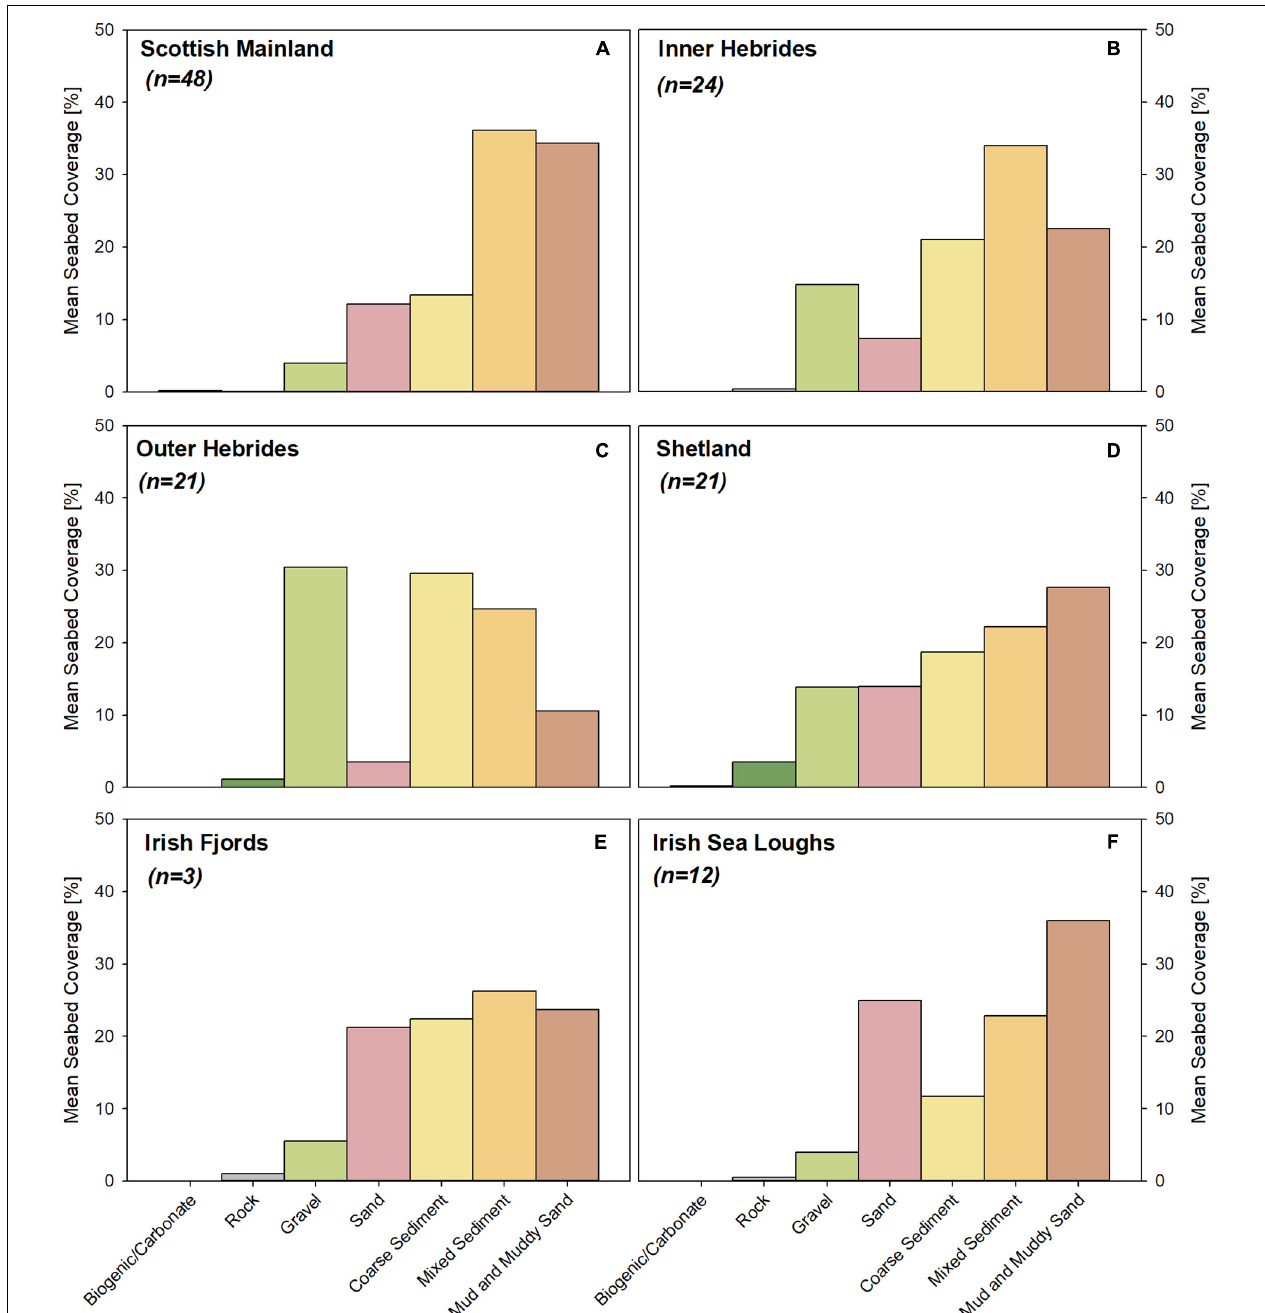
FIGURE 6 | Regional differences in mean seabed coverage (%) of the seven different sediment types across the fjords of (A) Mainland Scotland, (B) the Inner Hebrides, (C) the Outer Hebrides, (D) the Shetland Islands, (E) the fjords, and (F) sea loughs of